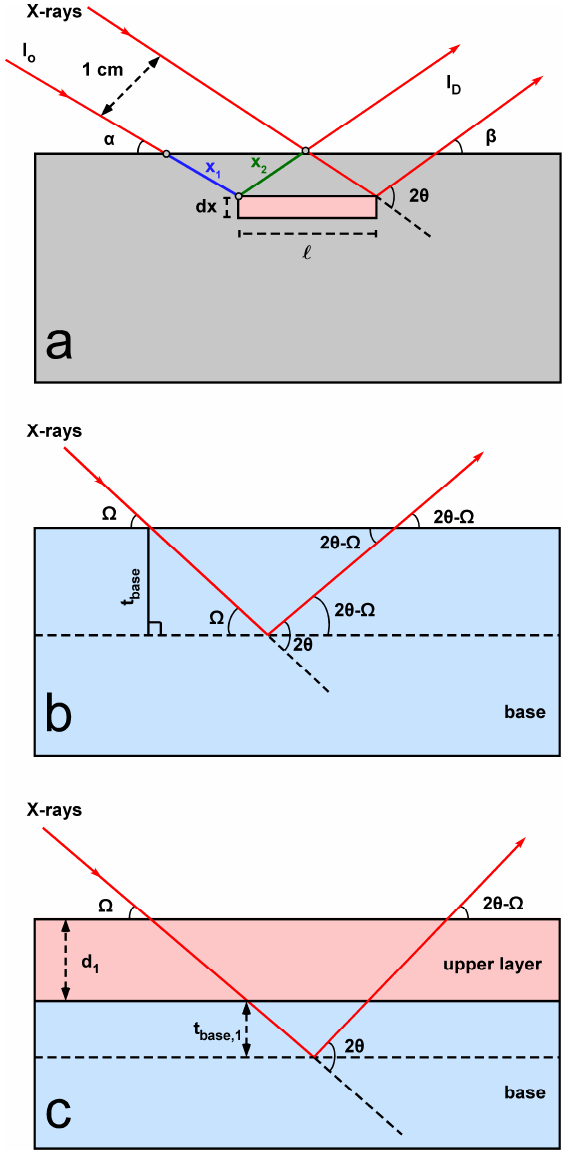
Figure 1. Schematic representation of X-ray diffraction in a flat sample. ( a ) Schematic representations of X-ray diffraction in a flat sample from the second layer of the examined material ( b ) and from both formed layers ( c ).